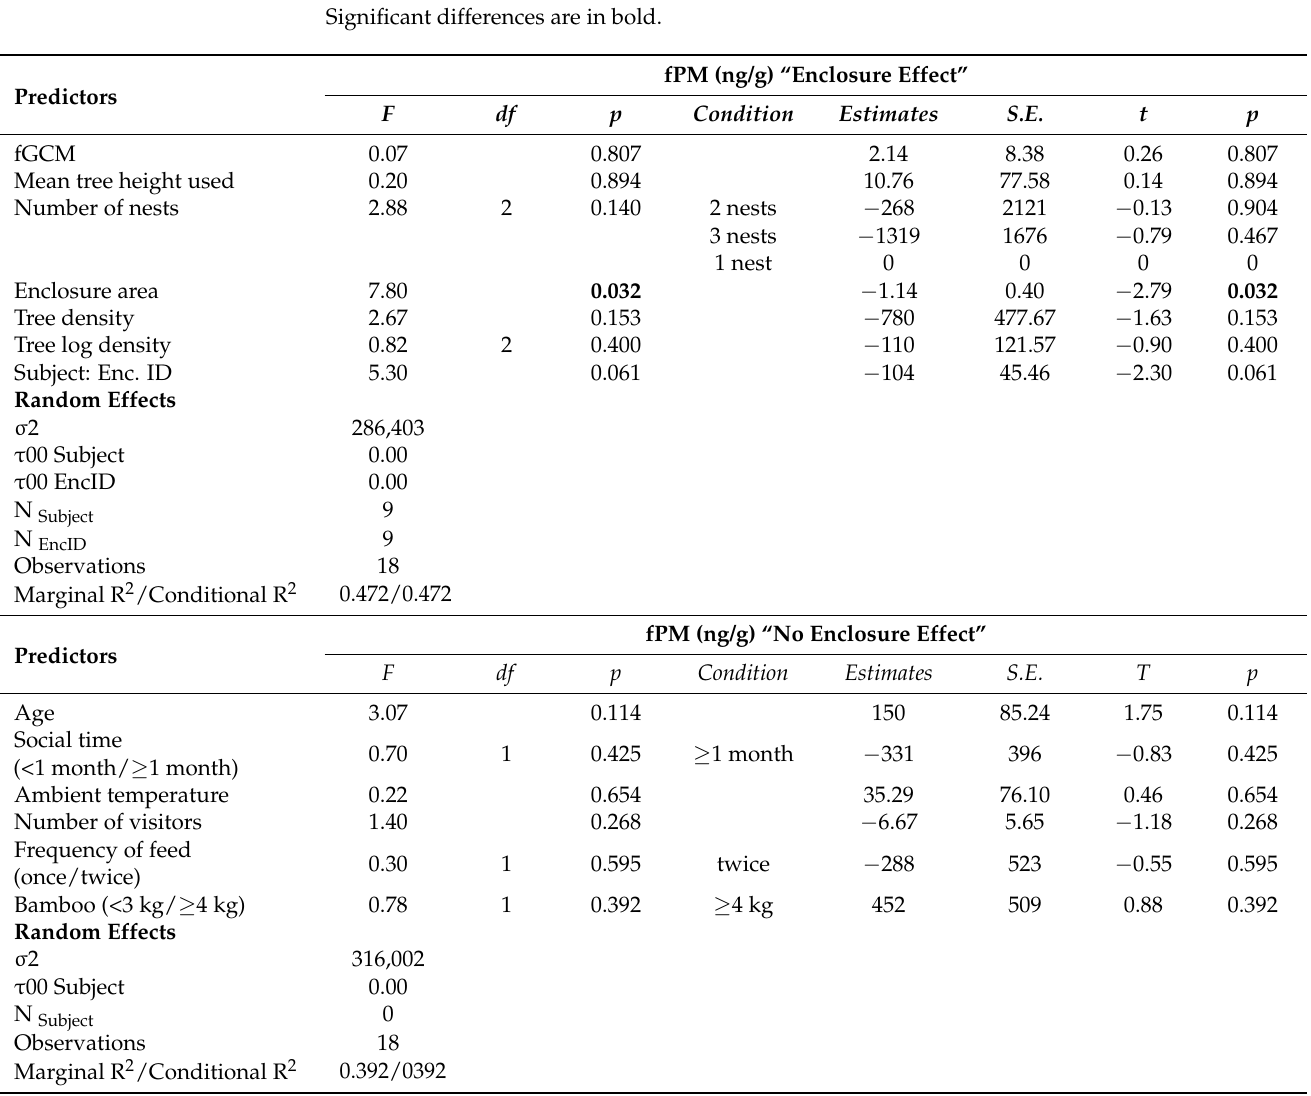
Table 3. Generalized linear mixed model (GLMM) analysis of the effect of biological and environ- mental covariates on fecal progestagen metabolites (fPM) of captive red pandas at three Indian zoos. Significant differences are in